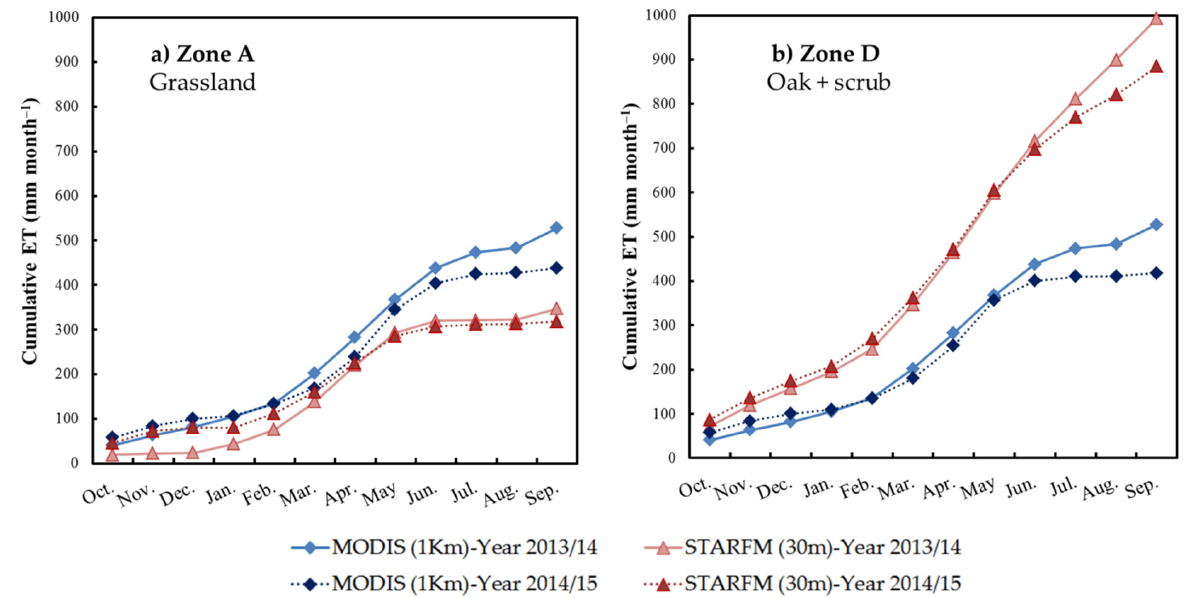
Figure 8. Evolution of cumulative monthly ET estimated by DisALEXI/MODIS and STARFM approaches for the hydrological year 2013/14 and 2014/15, over ( a ) zone A and ( b ) zone D.